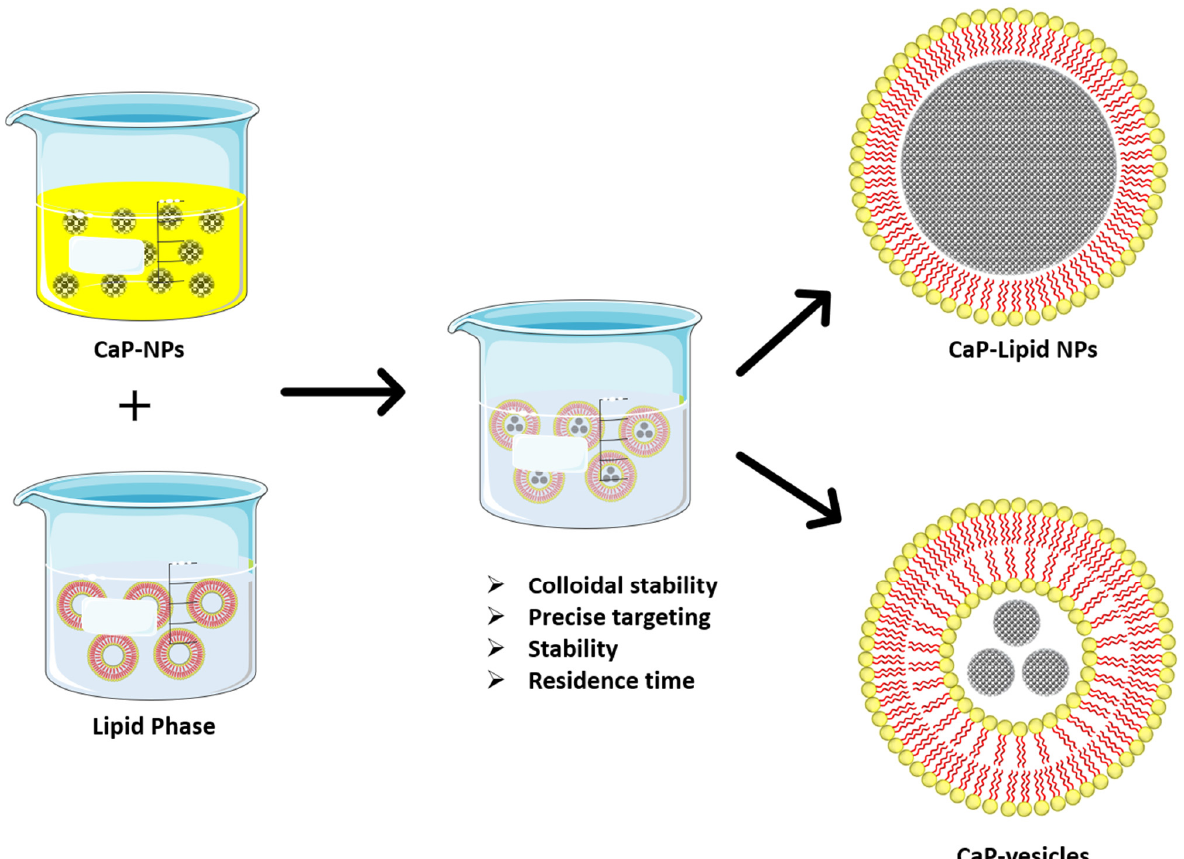
Figure 5. Lipid coating of calcium phosphate nanoparticles namely lipid nanoparticles and/or vesicles are either naturally derived (exosomes) or artificially (liposomes).